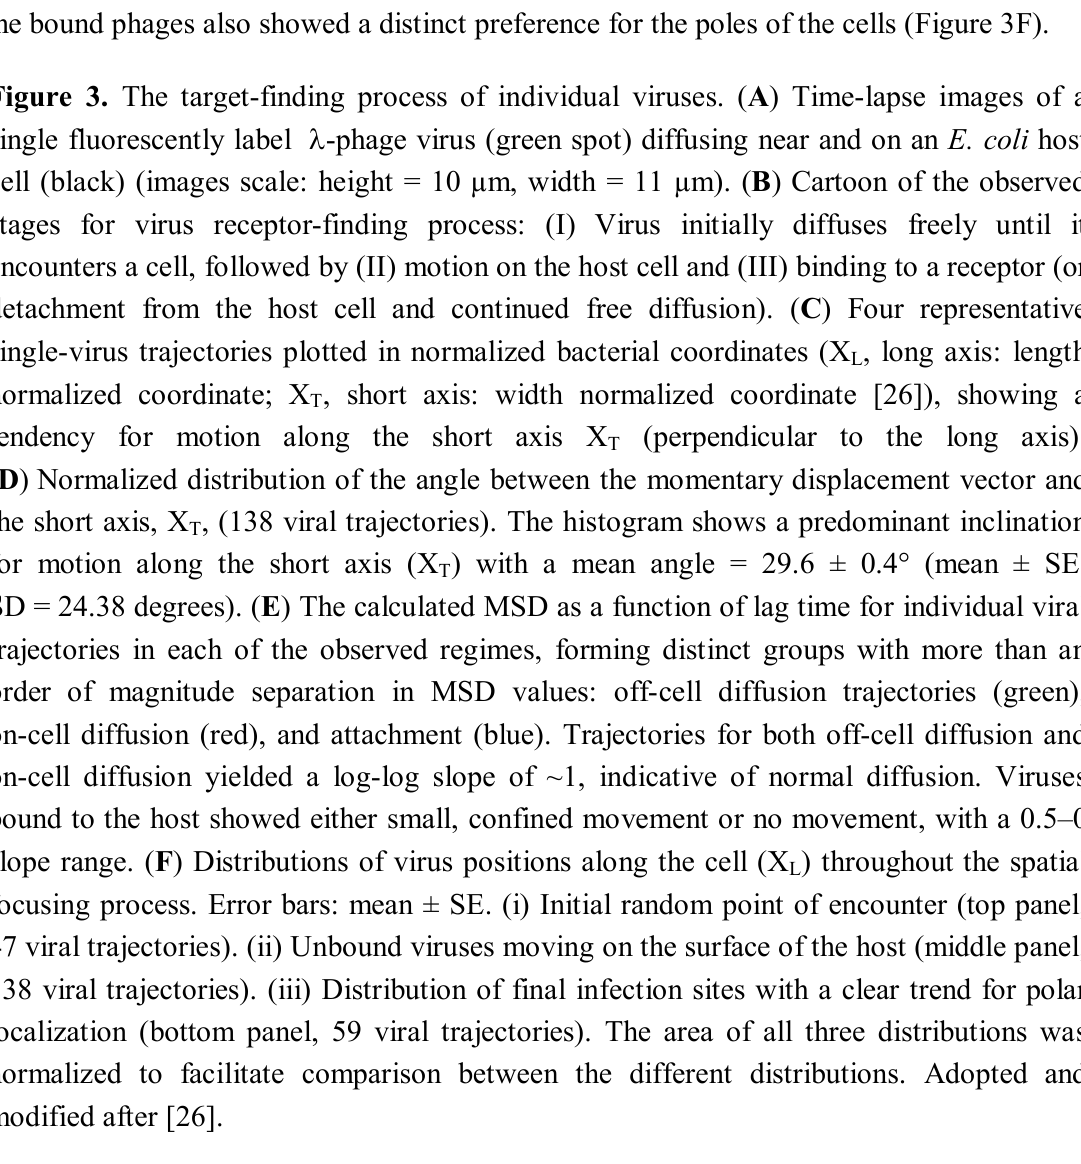
Figure 3. The target-fi nding process of individual viruses. ( A ) Time-lapse images of a single fluorescently label λ - phage virus (green spot) diffusing near and on an E. coli host cell (black) (images scale: height = 10 µm, width = 11 µ m). ( B ) Cartoon of the observed stages for virus receptor- finding process: (I) Virus initially diffuses freely until it encounters a cell, followed by (II) motion on the host cell and (III) binding to a receptor (or detachment from the host cell and continued free diffusion). ( C ) Four representative single- virus trajectories plotted in normalized bacterial coordinates (X , long axis: length L normalized coordinate; X , short axis: width normalized coordinate [26]), showing a T tendency for motion along the short axis X (perpendicular to the long axis). T